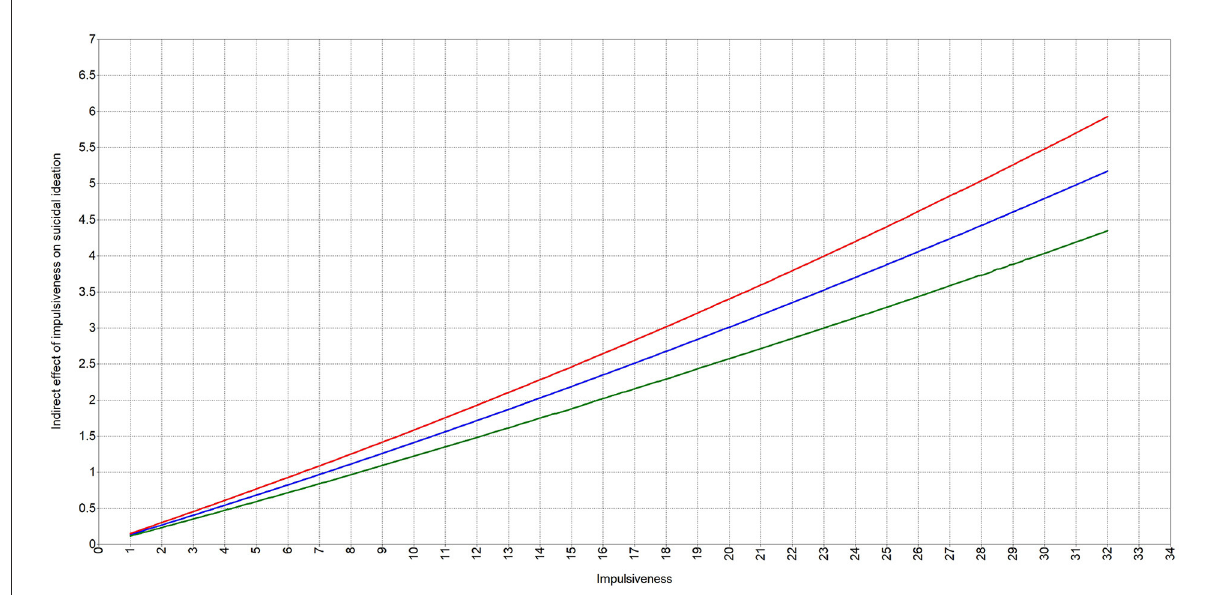
FIGURE4 Simple slope diagram. Red line—the indirect effect curve under condition of high impulsiveness; Blue line—the indirect effect curve under condition of medium impulsiveness; Green line—the indirect effect curve under condition of low